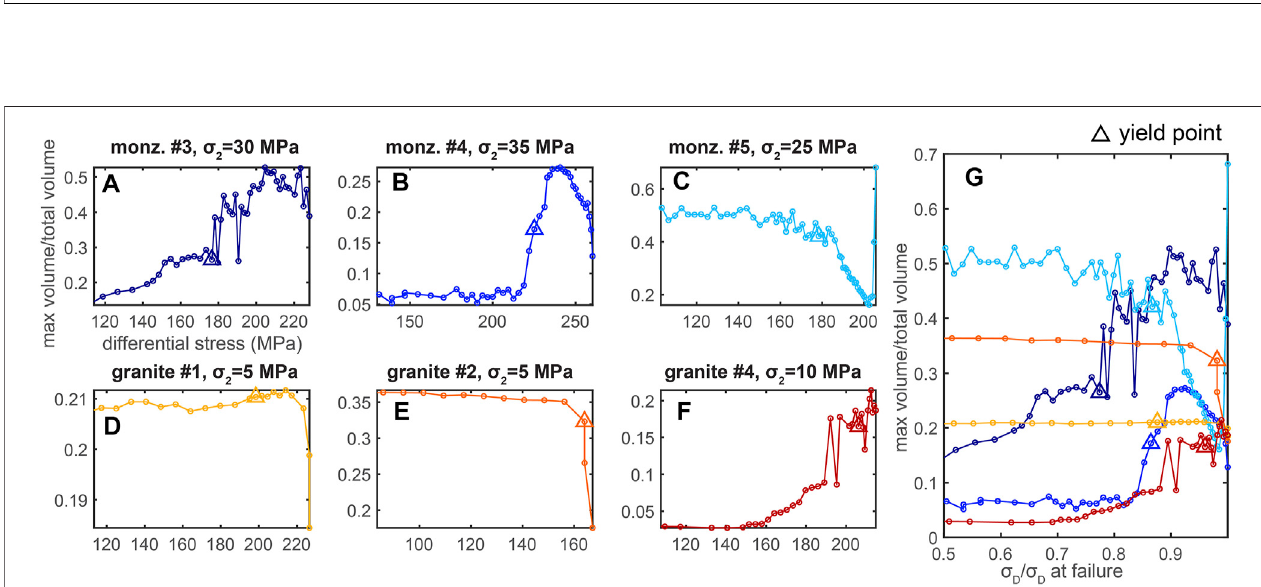
FIGURE4| Evolutionofthemaximumfracturevolumedividedbythetotalvolumeoffractures, v max /v tot ,throughouteachindividualexperiment (A – F) ,andforallthe experiments (G) . Color of the lines in (G) matches the colors of each experiment shown in (A – F) . Triangles show the conditions of the yield point. Increasing v max /v tot indicates that the fracture network is localizing toward the one largest fracture.